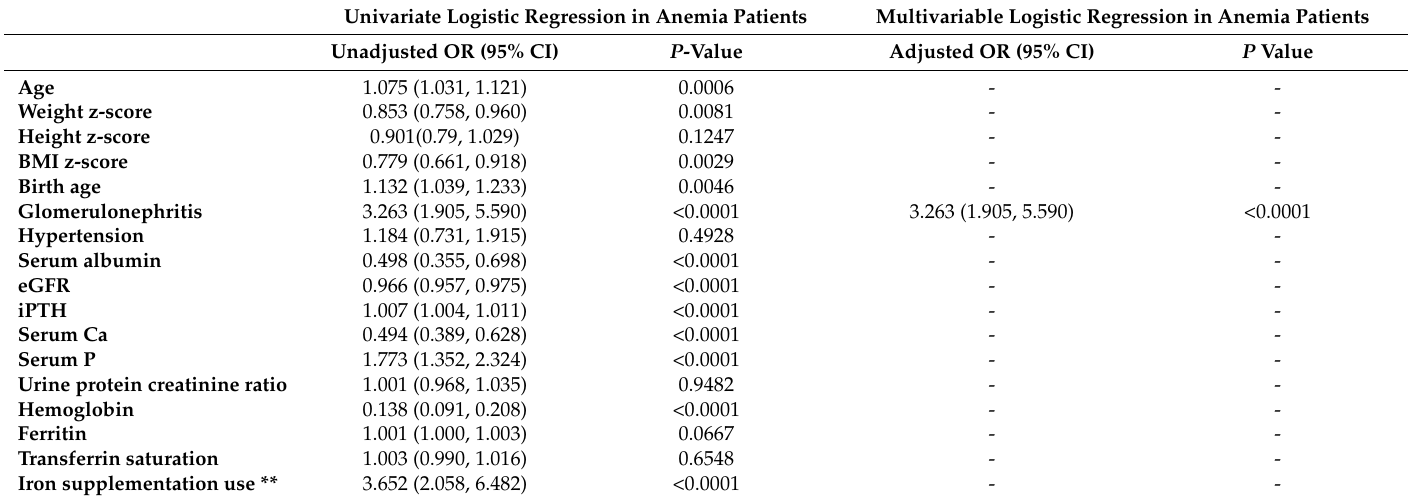
Table 6. Associated risk factors for anemia in patients with CKD who did not take erythropoietin-stimulating agents. Univariate Logistic Regression in Anemia Patients Multivariable Logistic Regression in Anemia